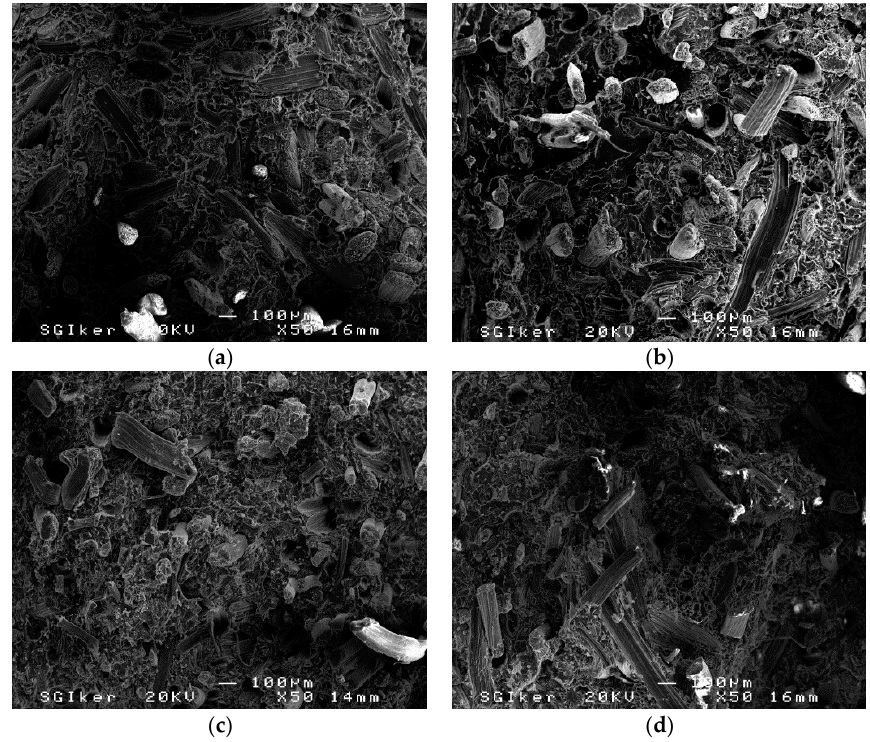
Figure 4. SEM micrographs of PLA/sisal composites (30 wt %) after water uptake period: ( a ) untreated; ( b ) silane; ( c ) NaOH; and ( d ) NaOH + silane.